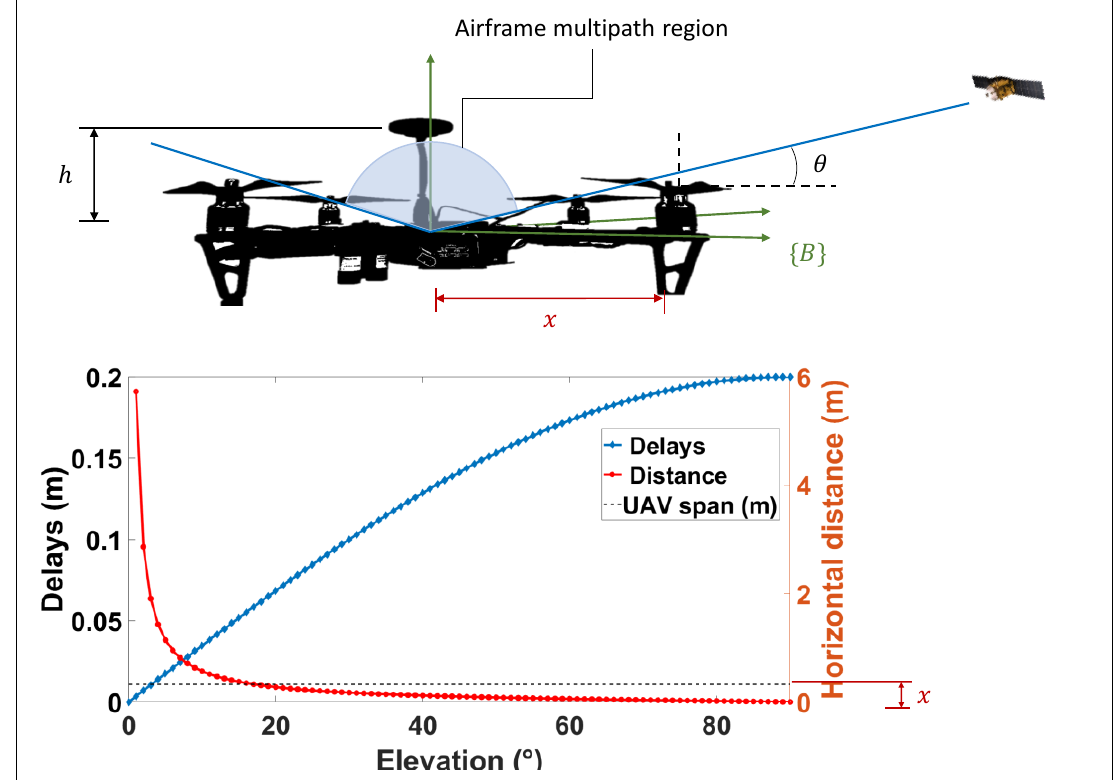
Figure 9. Multipath region for a small UAV (owing to reflections from the aircraft body).